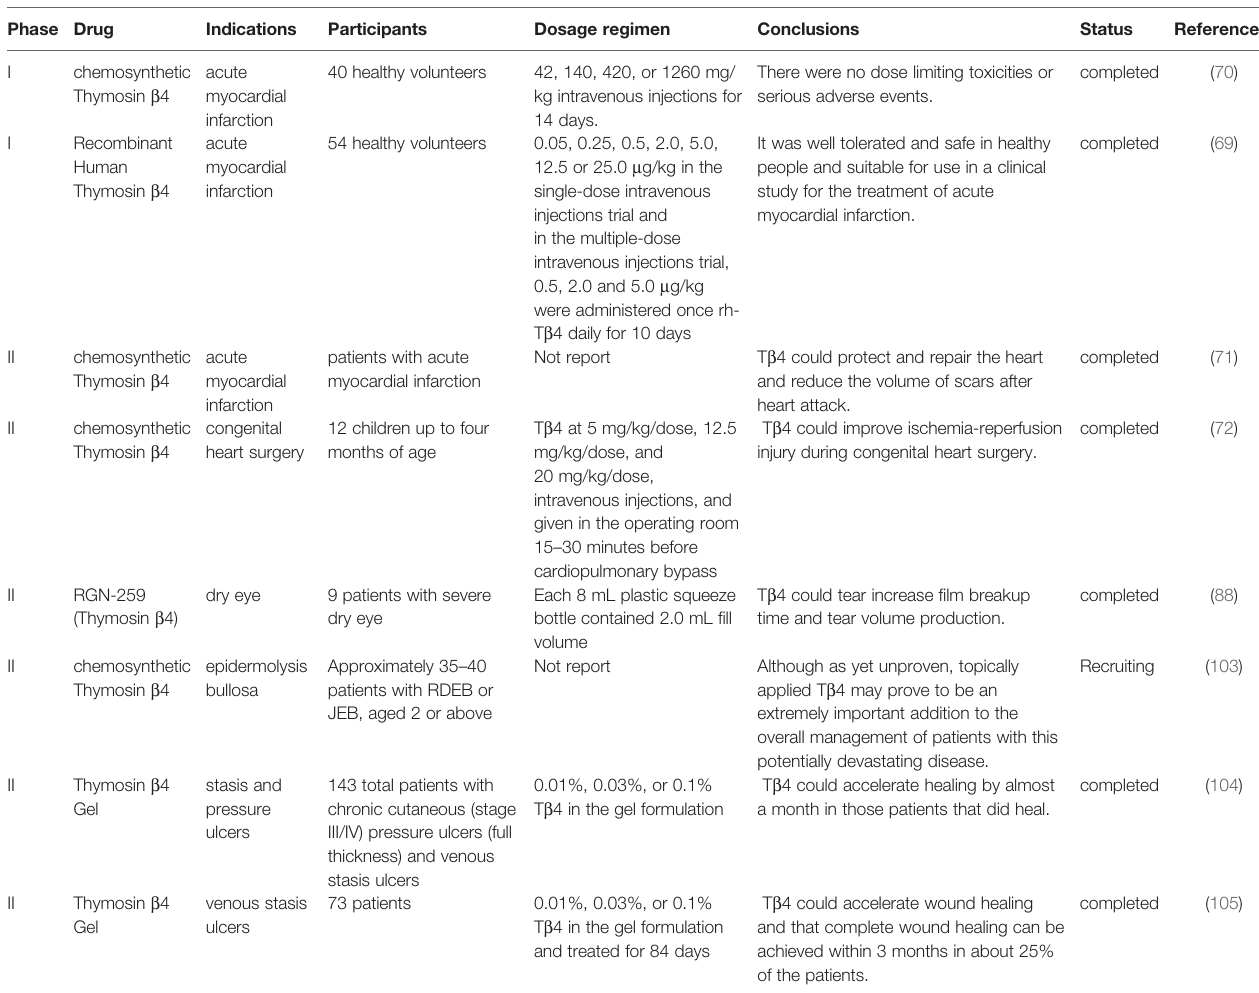
TABLE 2 | Clinical trials of T b